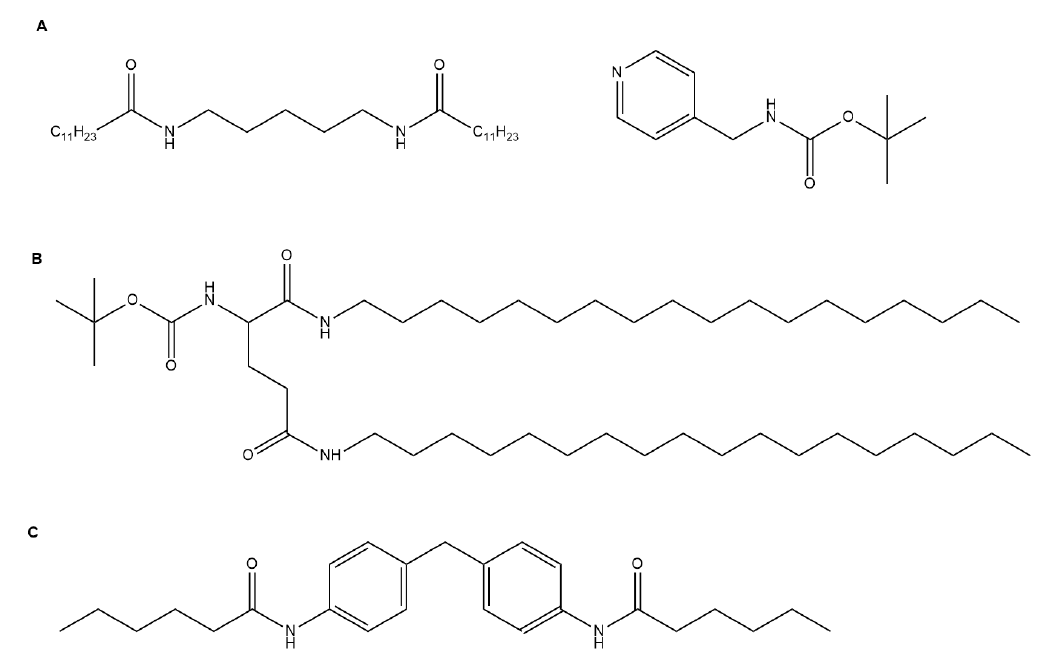
Figure 6. Selected gelators developed for energy applications: ( A ) Co-assembled N ′ -1, 5-pentanediylbis-dodecanamide and 4-(Boc-aminomethyl)pyridine gelators for solar energy generation [61]; ( B ) a thylakoid membrane-inspired organogel for photon up-conversion [63]; and ( C ) a supercapacitor bis(4-acylaminophenyl)methane gelator [64].